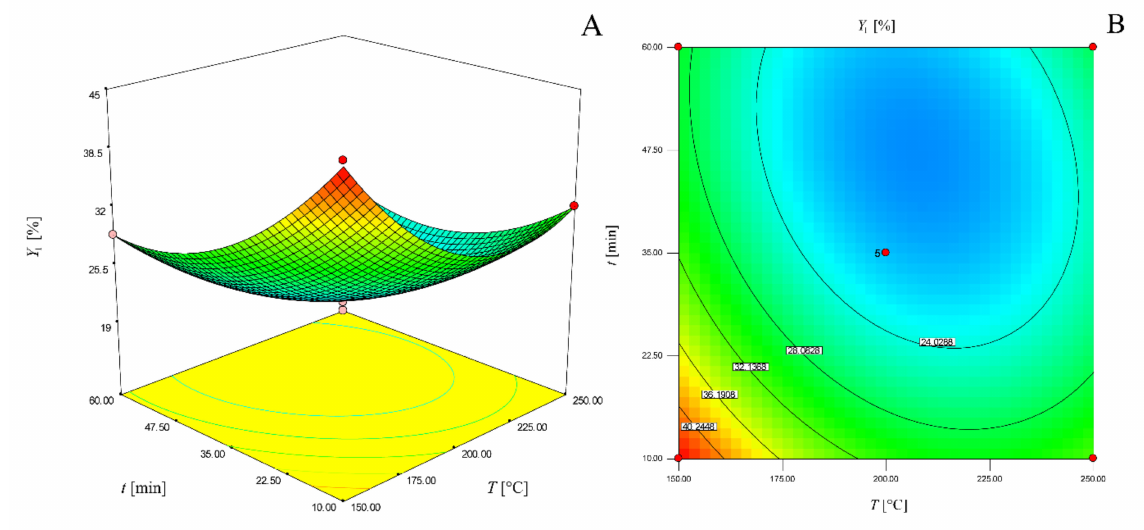
Figure 1. Three-dimensional response surface ( a ) and two-dimensional contour plot ( b ) of the model for determination of chestnut bark extraction yield for solvent-solid ratio of 20 mL /